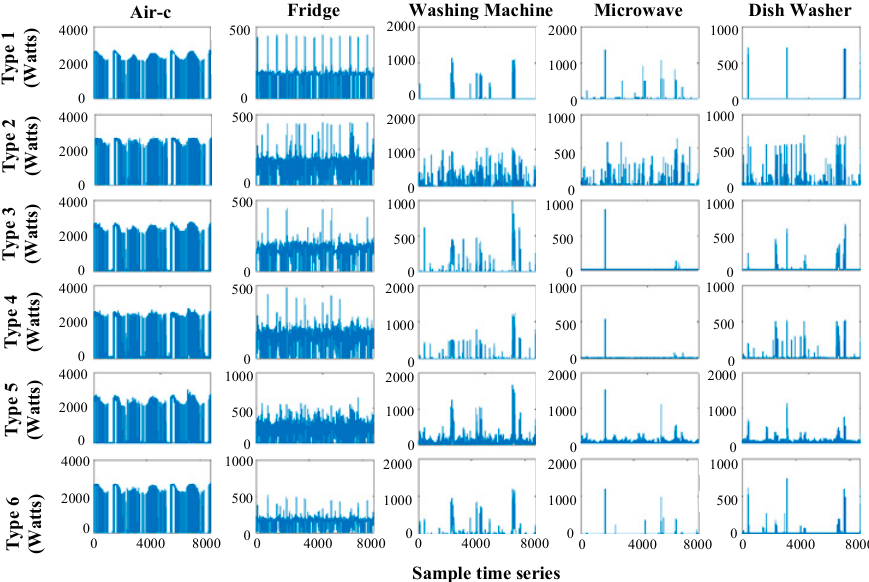
Figure 10. Comparison of the load power of different types of equipment.